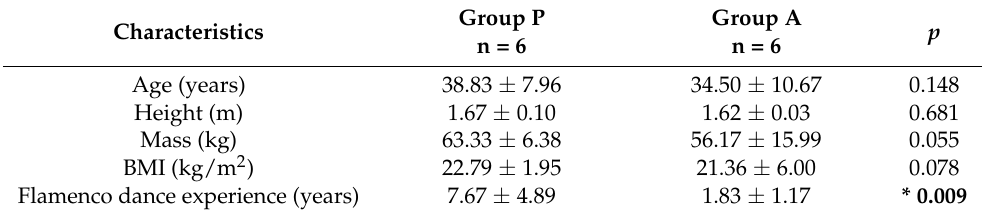
Table 1. Descriptive characteristics of participants (n =